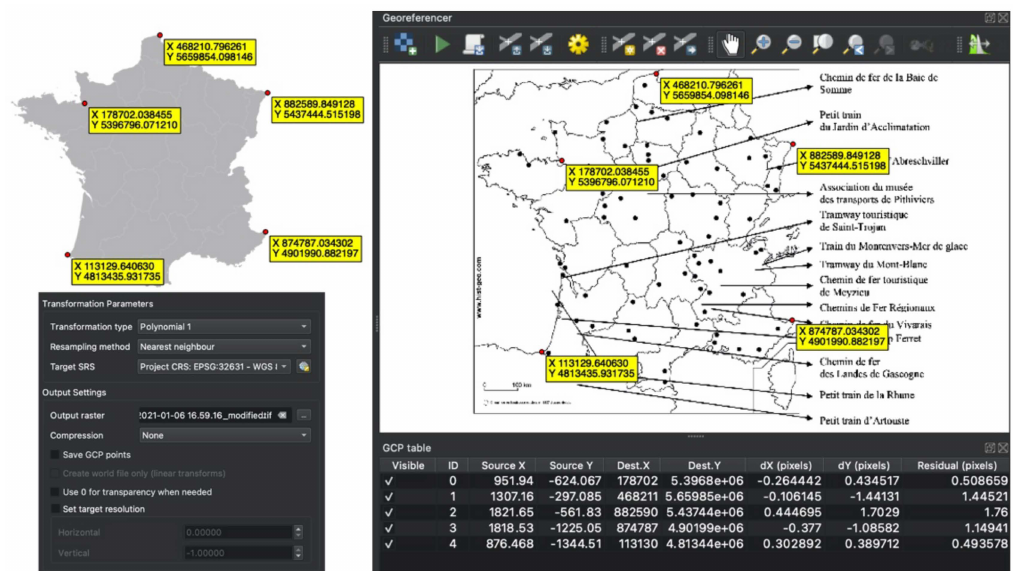
Figure 3. Georeferencing maps.